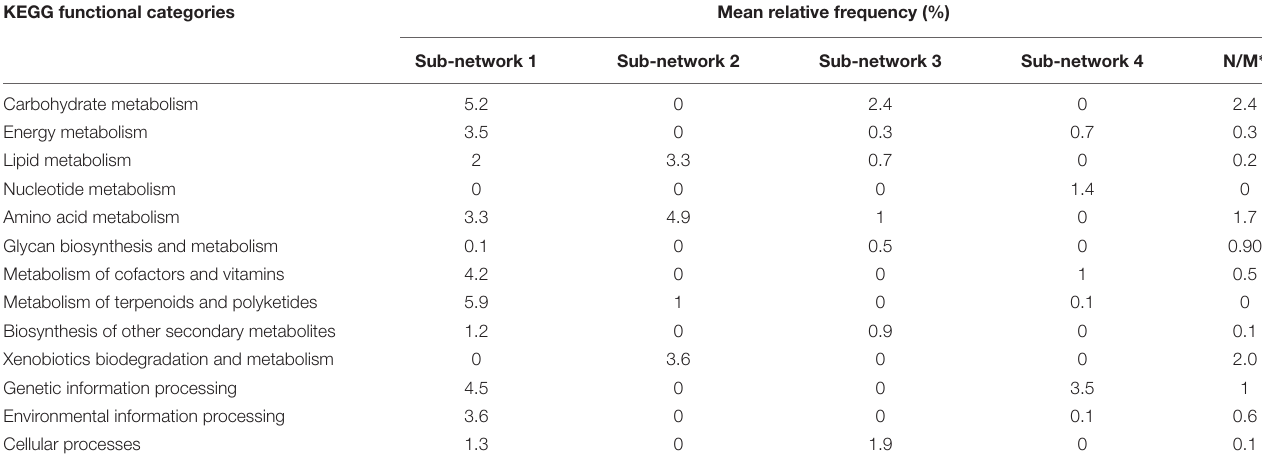
TABLE 2 | Distribution of KEGG functional categories in the pathway co-occurrence network.